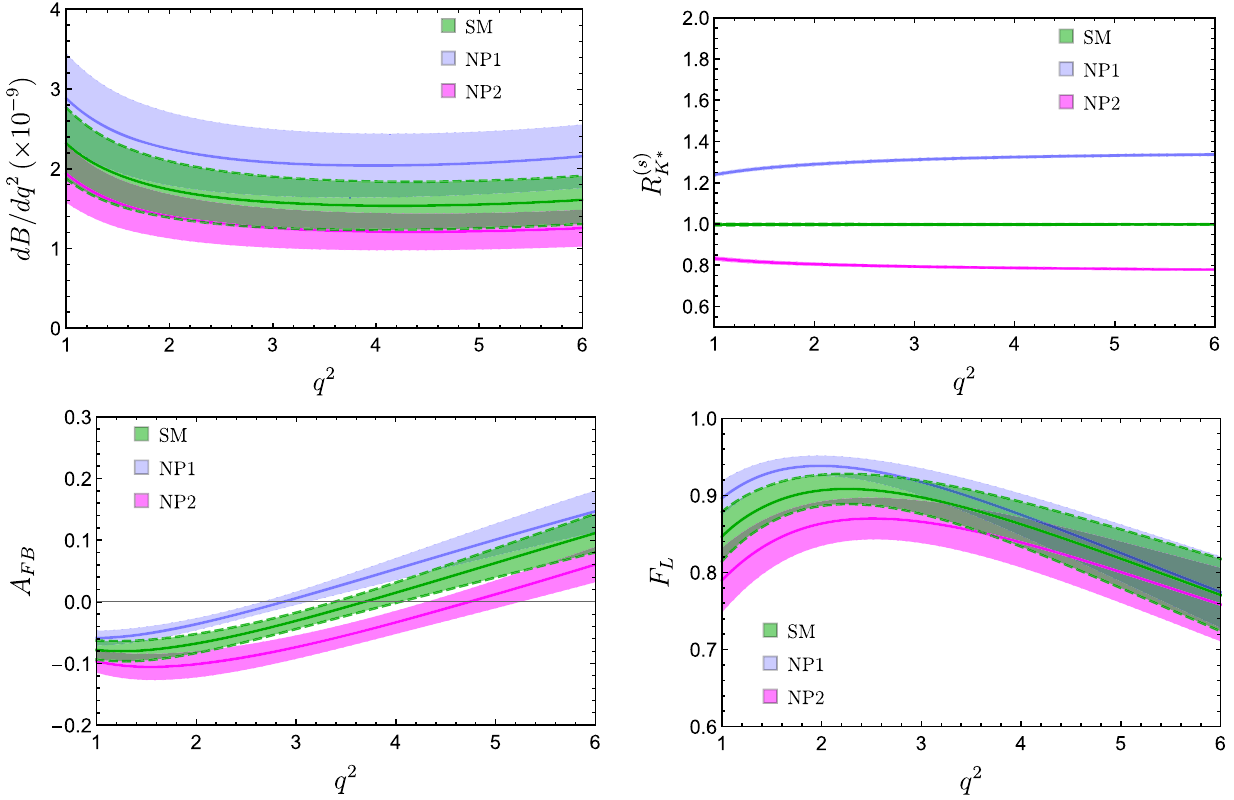
Fig. 3 The predictions for observables in B s → ¯ K ∗ μ + μ − decay, with real Z (cid:3) couplings, for SM and the benchmark scenarios NP1 and NP2 as in Table